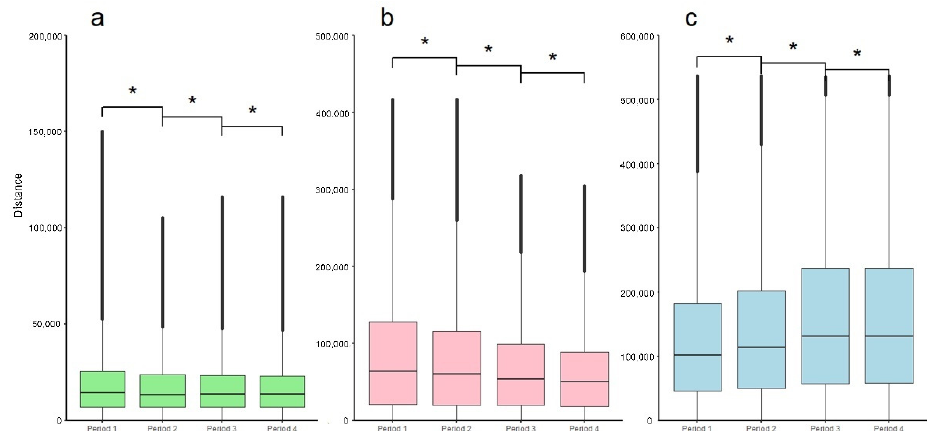
Figure 4. The differences of the three variables in the four periods: ( a ) dis_fp; ( b ) dis_la; ( c ) dis_wl. Period 1 is 2000 − 2004, Period 2 is 2005 − 2009, Period 3 is 2010 − 2014, and Period 4 is 2015 − 2019. The asterisks indicate a significant difference.